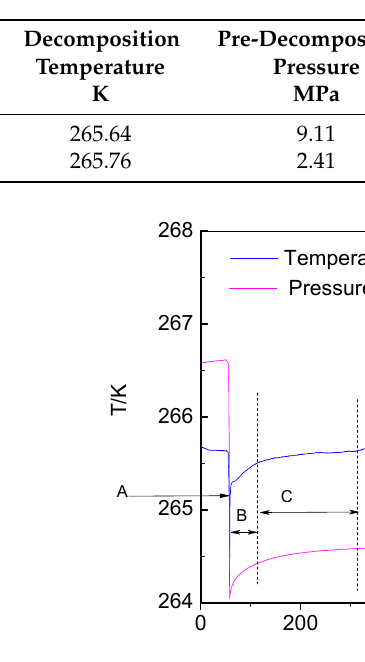
Table 3. Description of decompositions.